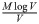
Finite-size effects.We plot 1 − M
acc/M (top) and the total length per node L/V (bottom) for Reg (left) snd ER (right) graphs as a function of the scaling variable MlogVV. We can notice the finite-size effects decreasing with system size leading to the curves corresponding to the biggest graphs V = 8000,10000 to almost superimpose. Note that in the SAT phase the total length grows linearly in log V for all system sizes as expected but in the UNSAT phase the graphs split. Error bars are smaller than point size.